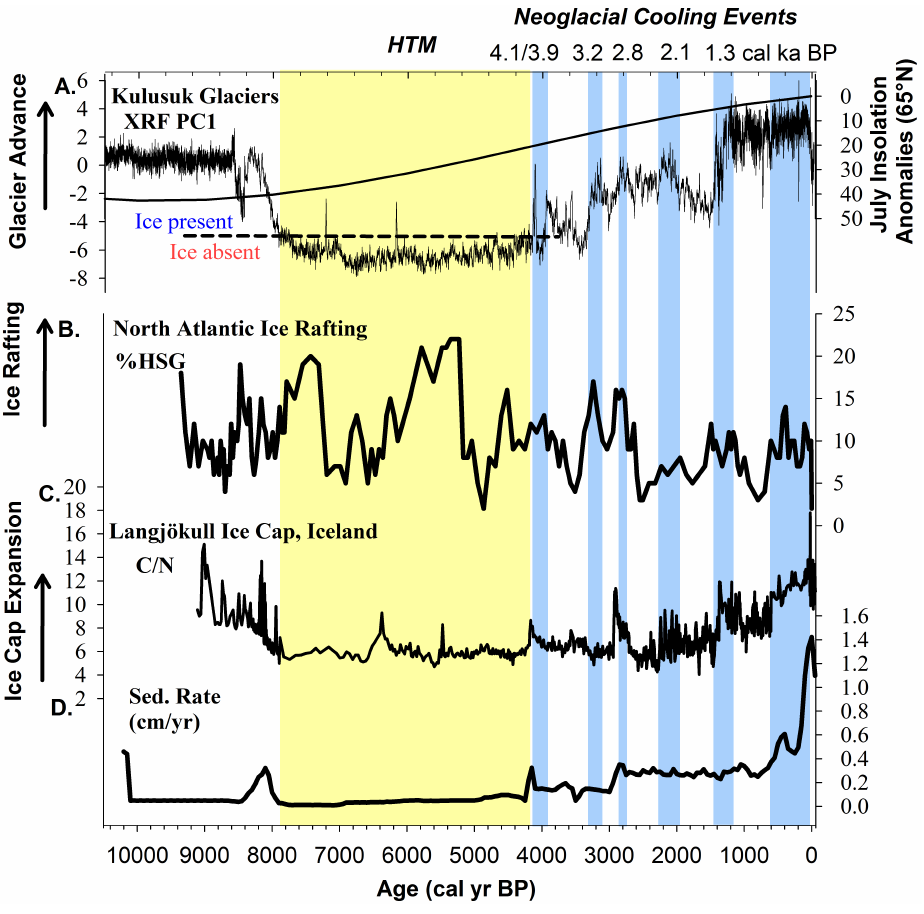
Figure 4. Regional response of glaciers to Holocene climate changes. (a) Kulusuk glaciers interpreted from PC1 data with July insolation anomalies at 65 ◦ N (Berger and Loutre, 1991). (b) Hematite-stained grains (HSG) identified in core MC52-VM29-191 interpreted to indicate ice-rafting events (Bond et al., 1997). (c) Ratio of total organic carbon to total nitrogen (C / N) and (d) changes in sedimentation rate from Hvítárvatn, interpreted to reflect changes in the size of the Langjökull ice cap, Iceland, and catchment instability in response to climate cooling (Larsen et al., 2012). Yellow shading marks the timing of the Holocene Thermal Maximum (HTM), as interpreted at Kulusuk, and the dashed line on the PC1 plot shows where we have interpreted the absence of ice from the catchment during the HTM. Blue bars highlight intervals of glacier advance and increased ice rafting that define Neoglacial cooling events comparable among the